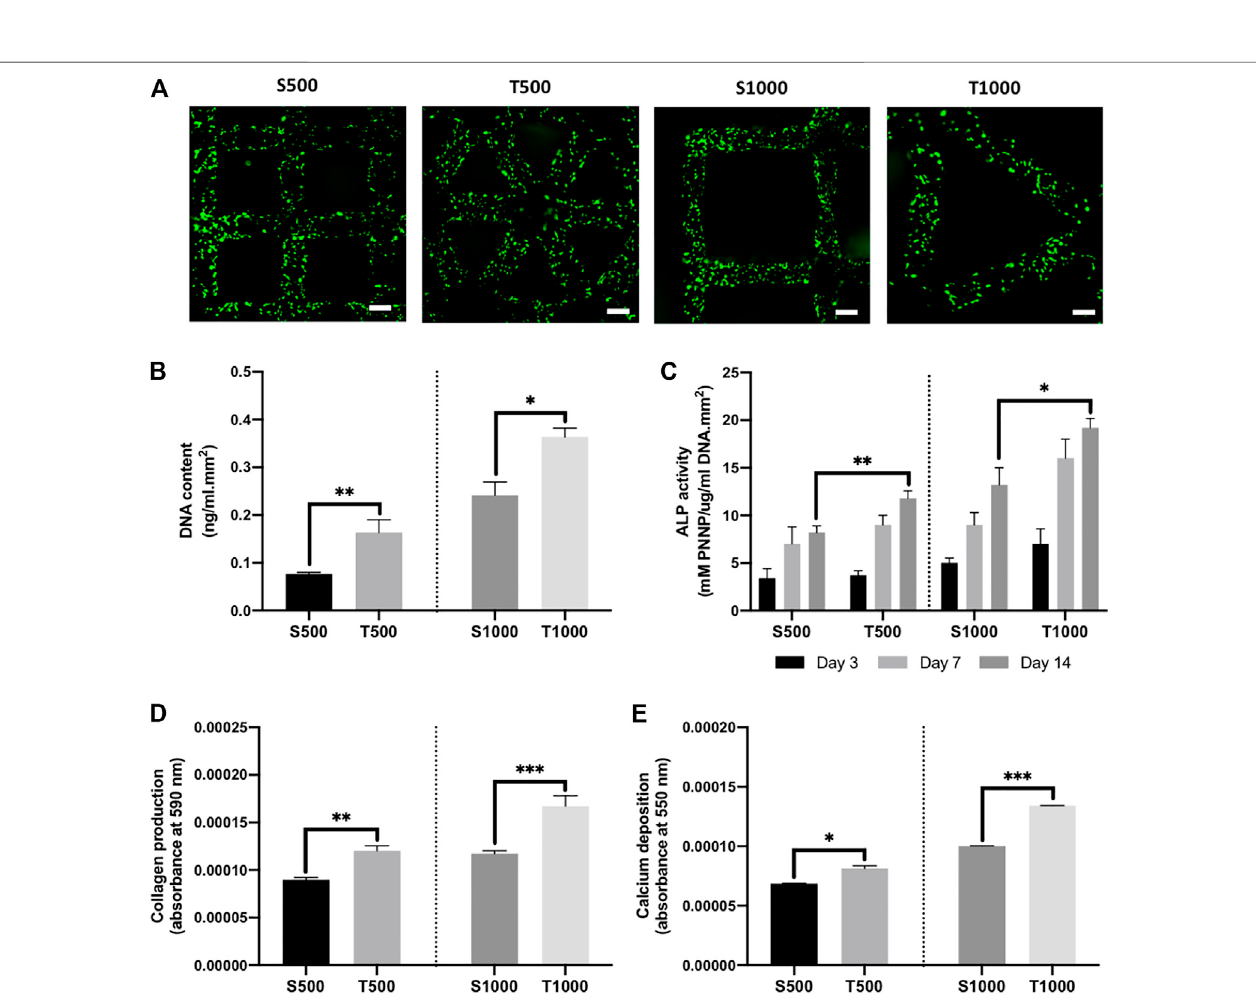
FIGURE 3 | In fl uence of titanium scaffold architecture on osteoblast behaviour and mineralisation. (A) Live/dead staining of osteoblasts cultured on titanium scaffoldsfollowingdynamicseeding,scalebar (cid:2) 200 µm.Theeffects ofscaffolddesignonosteoblast (B) DNAcontent, (C) ALPactivity, (D) collagenproduction and (E) calcium deposition following 14 days osteogenic culture. Data are expressed as mean ± SD (n (cid:2) 3). *P ≤ 0.05, **P ≤ 0.01 and ***P ≤ 0.001.